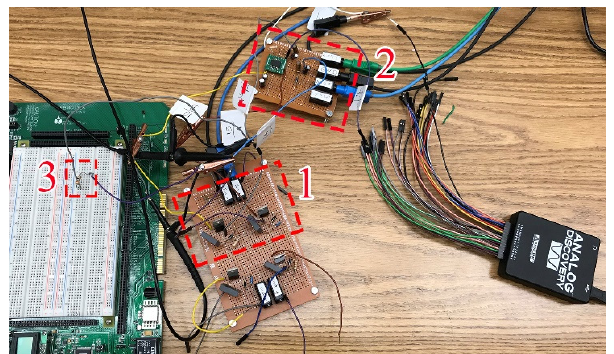
Figure 12. Testing the half-bridge GaN inverter with RCD snubber circuits; 1: Half-bridge inverter, 2: Gate Driver, 3: Load.